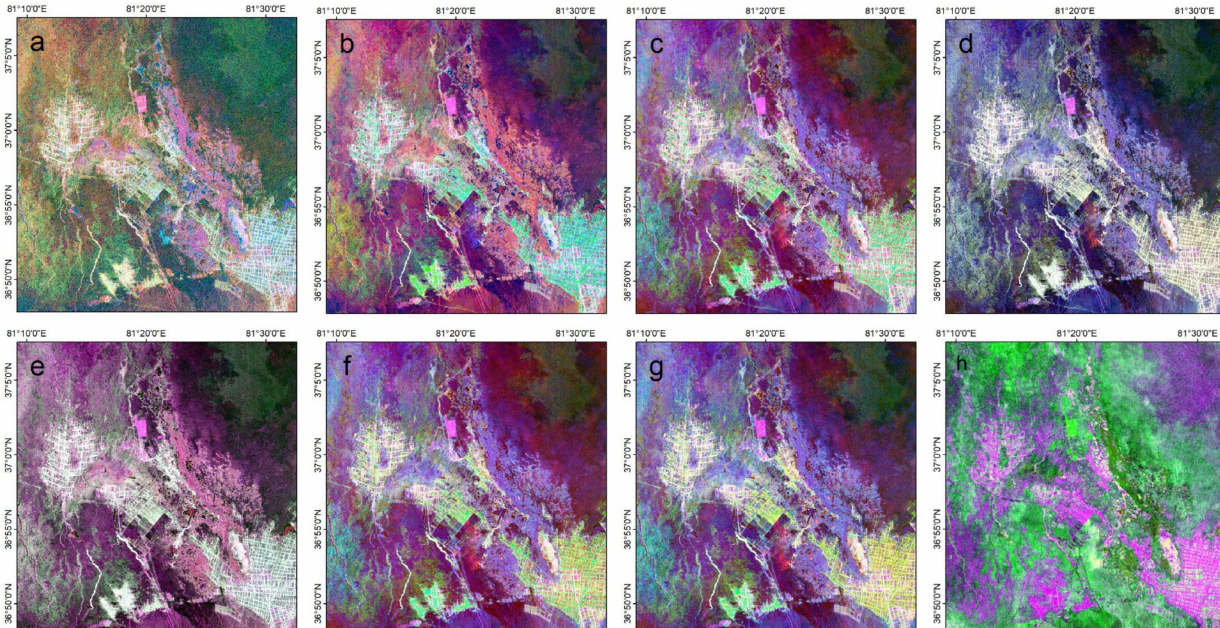
Figure 6. The polarization decomposition results of the RGB standard composite image obtained by: ( a ) Cloude; ( b ) Freeman; ( c ) Freeman Durden; ( d ) Pauli; ( e ) Sinclair; ( f ) VanZyl; ( g ) Yamaguchi; ( h ) H/A/Alpha decomposition